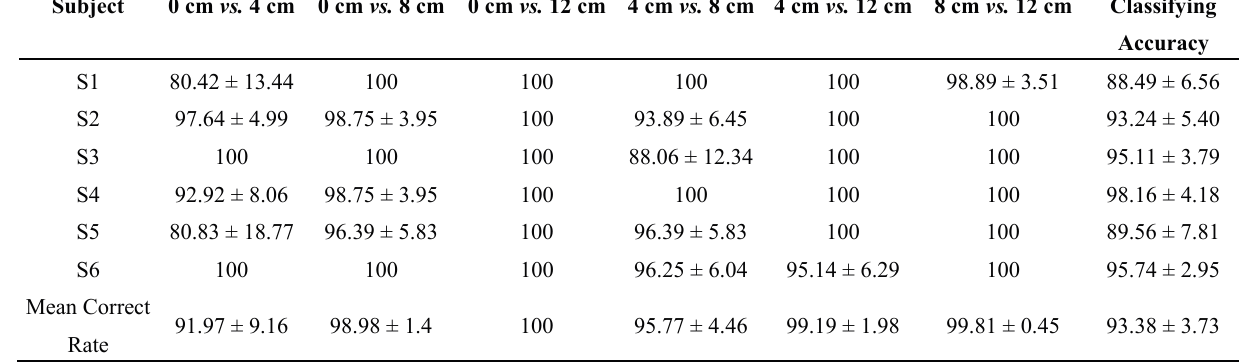
Table 1. Classification accuracies in % for classifying test